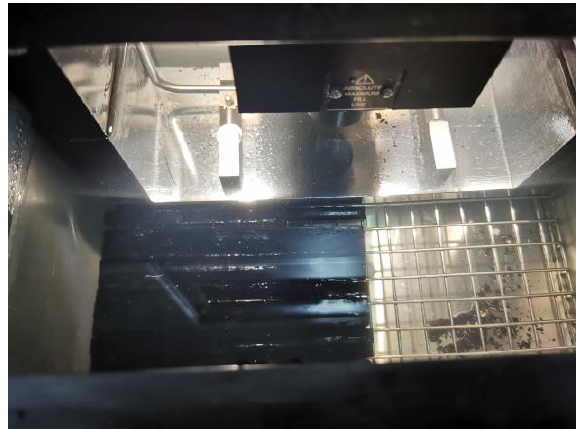
Figure 3. (Bending beam rheometer) BBR